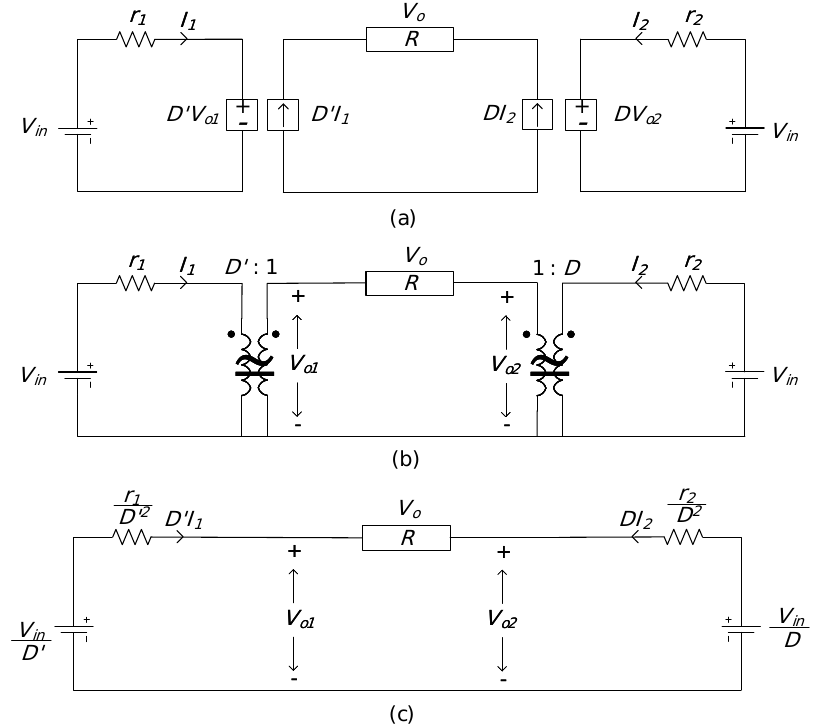
Figure 5. The steady-state equivalent model of the boost inverter. ( a ) Steady-state equivalent from the equations, ( b ) standard canonical approximation, and ( c ) simplified equivalent model.